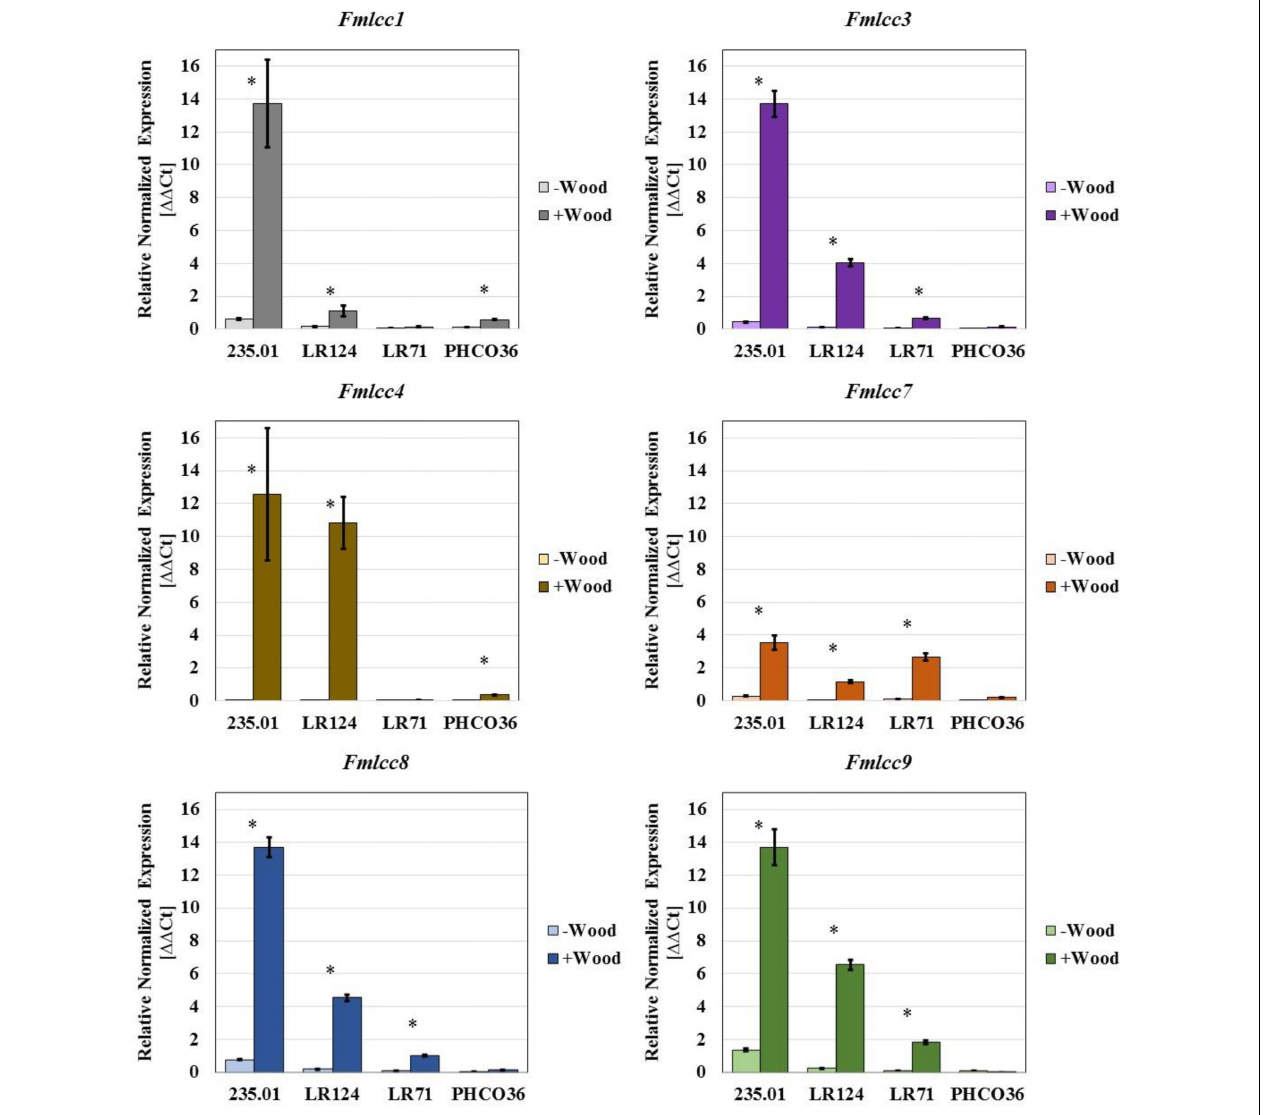
FIGURE 9 | Gene expression of six laccase isoforms measured in 4 different strains of Fmed. Data are expressed as relative normalized expression of genes with cv. Gewurztraminer wood sawdust (+ Wood) and without sawdust (–Wood) compared to the mean of (cid:49) CT of samples grown without wood sawdust. The asterisk denotes significant difference in Student’s t -test ( p ≤ 0.05) between gene expression with and without wood sawdust. Error bars on histograms represent the standard error of the